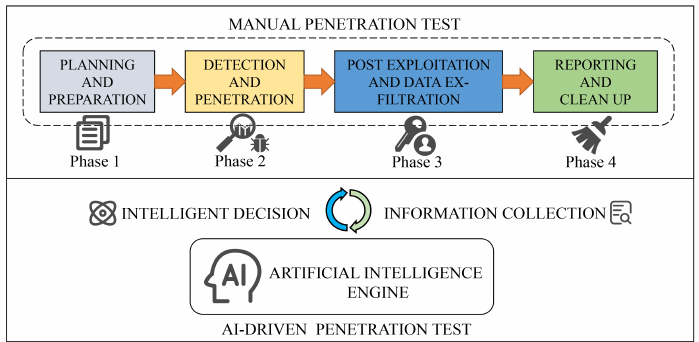
Figure 2. Comparison of manual penetration test with AI-driven penetration